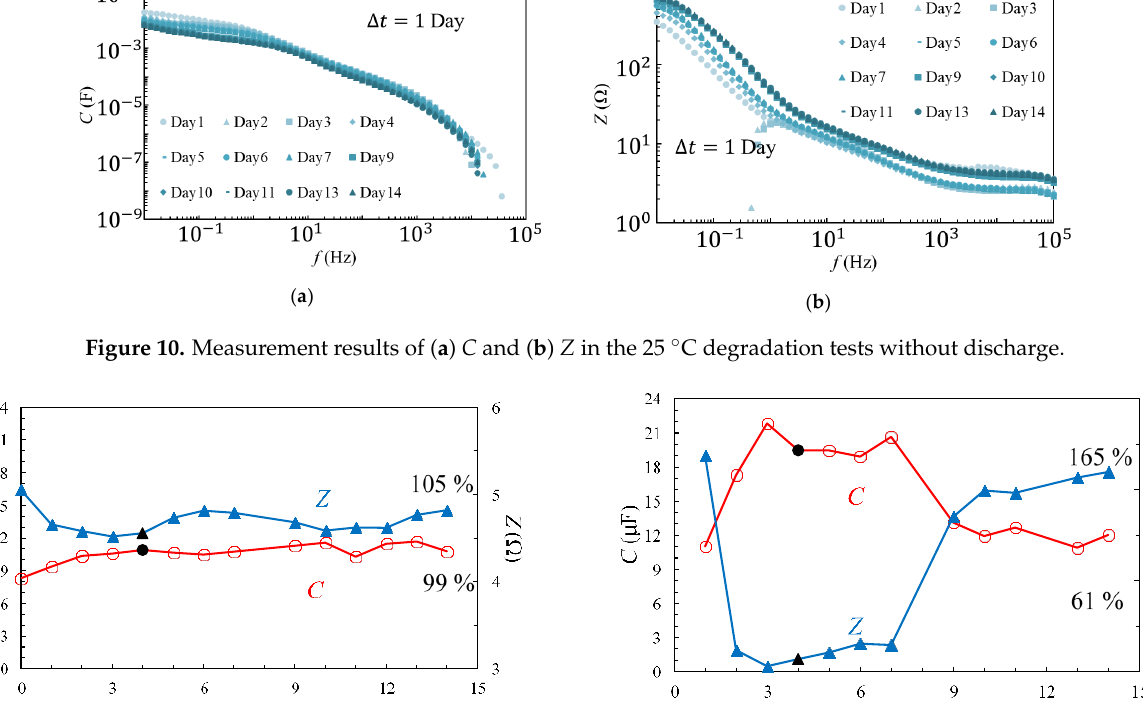
Figure 9. Measurement results of ( a ) C and ( b ) Z in the 25 °C degradation tests with discharge.